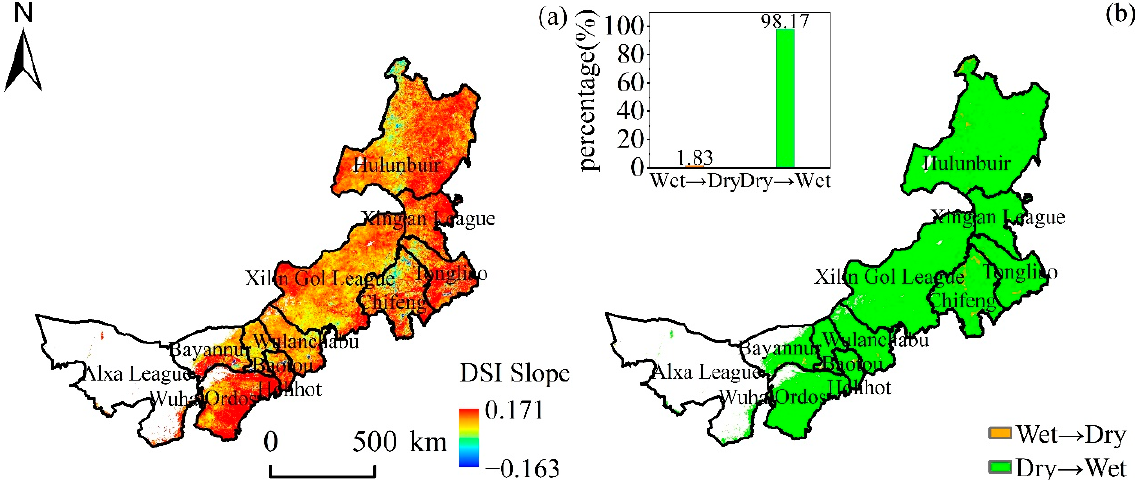
Figure 2. Trends in Inner Mongolia’s DSI index from 2001 to 2020: spatial DSI patterns ( a ); wetting and drying trends ( b ).